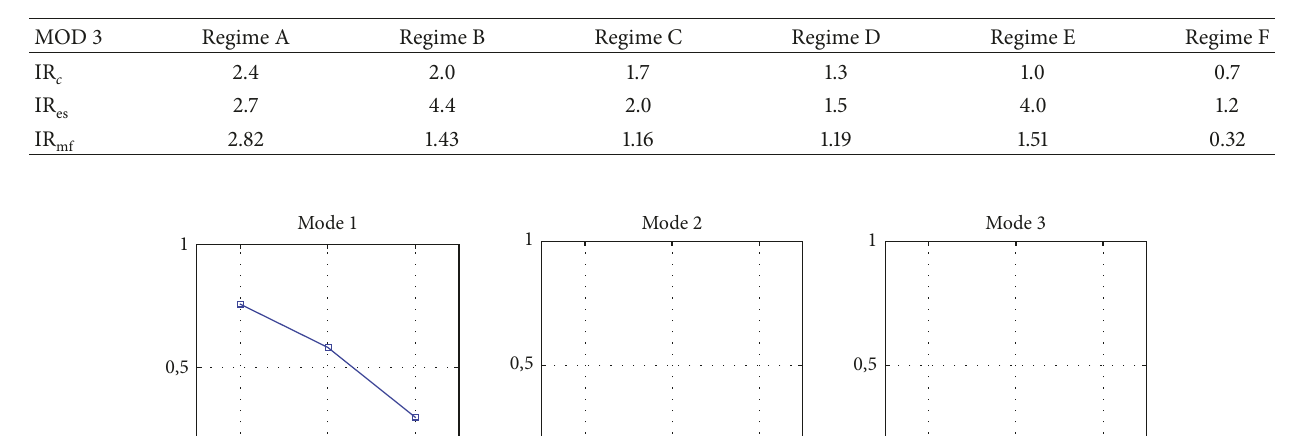
Table 12: Simulation results of MOD 3.